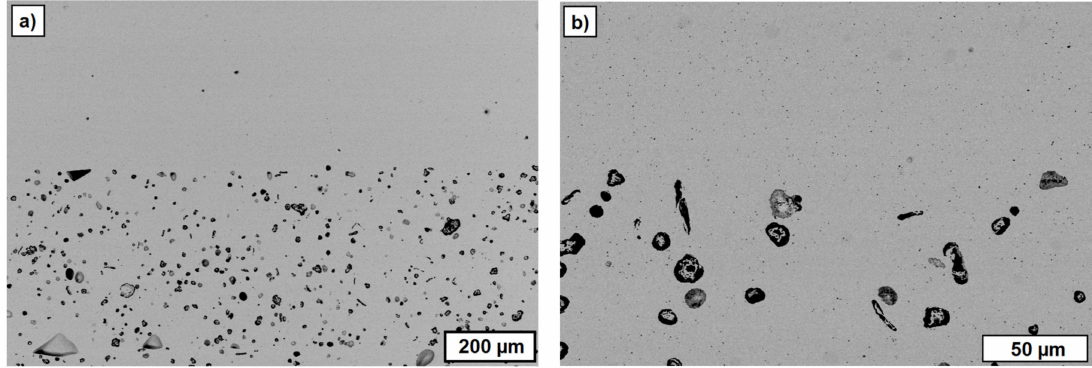
Figure 21. FESEM images of cross-sections of sintered zirconia 4D components; the interface between dense and porous areas; ( a ) overview; ( b ) detail.